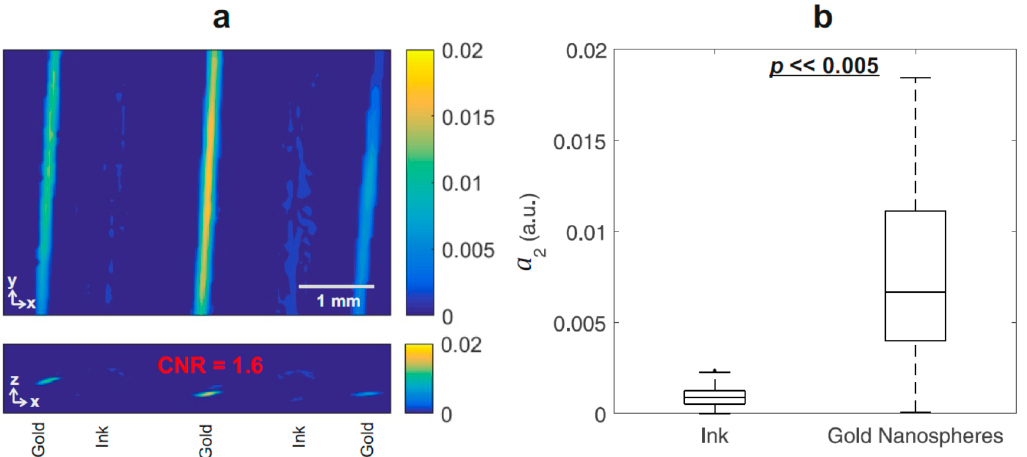
Figure 4. Results of Method I (linear regression). ( a ) xy ‐ and xz ‐ MIPs of the coefficient of determination o f a linear regression, (cid:1844) (cid:3039)(cid:3036)(cid:3041)(cid:2870) ( Equation 1) applied to the PA image intensity as a function of fluence for each voxel of a 3D PA image. The contrast ‐ to ‐ noise ratio (CNR) computed with (cid:1844) (cid:3039)(cid:3036)(cid:3041)(cid:2870) is also reported. ( b ) Boxplot of (cid:1844) (cid:3039)(cid:3036)(cid:3041)(cid:2870) for the tubes filled with gold nanospheres compared with those filled with India ink.